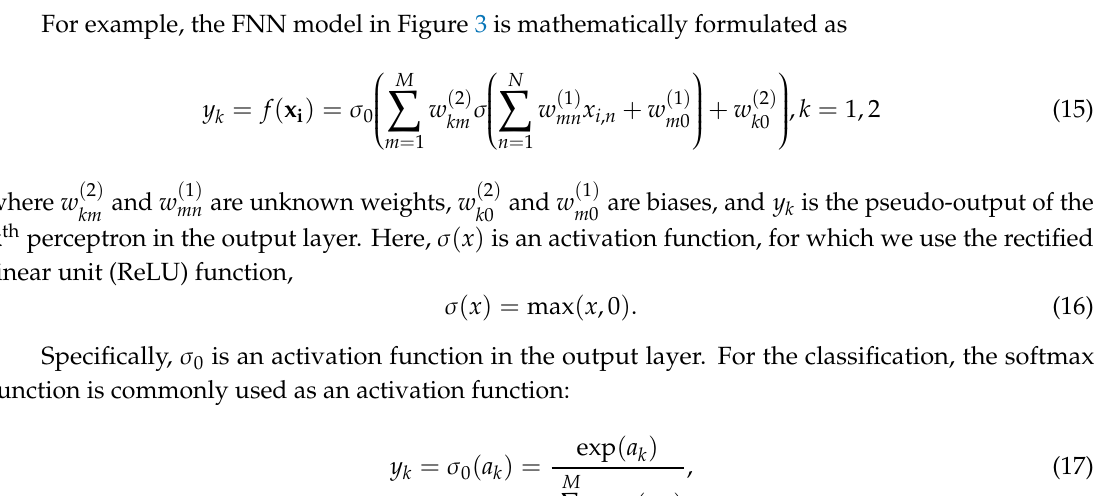
Figure 3. Structure of feedforward neural network with one hidden layer for classification with k classes.